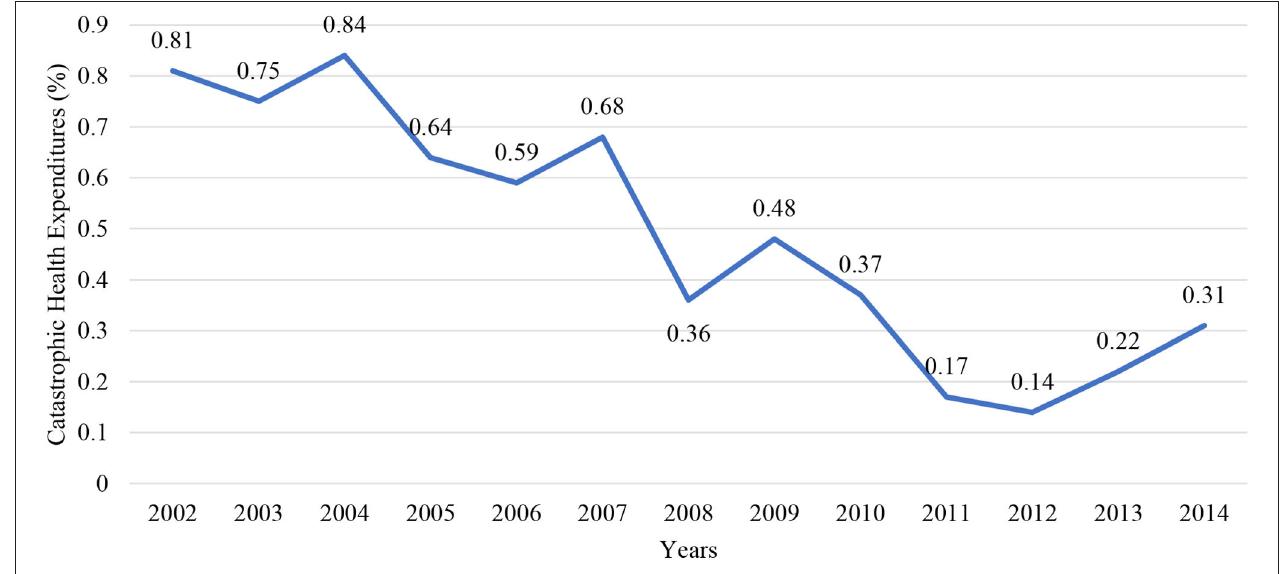
FIGURE 2 | Catastrophic health expenditures by years (2002–2014) (24).